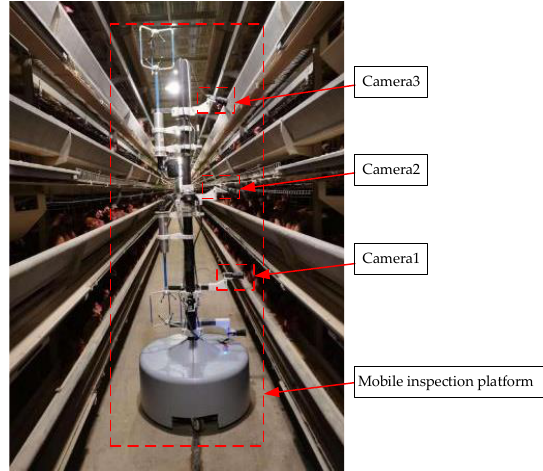
Figure 1. T he image acquisition system and housing condition of laying hens.